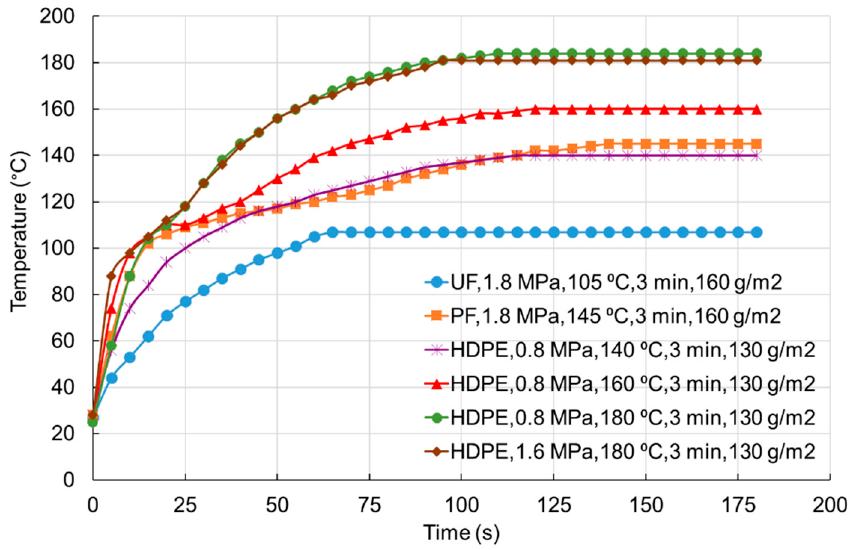
Figure 4. Core-layer temperature curves of three-layer plywood prepared with different adhesives at various hot-pressing conditions.